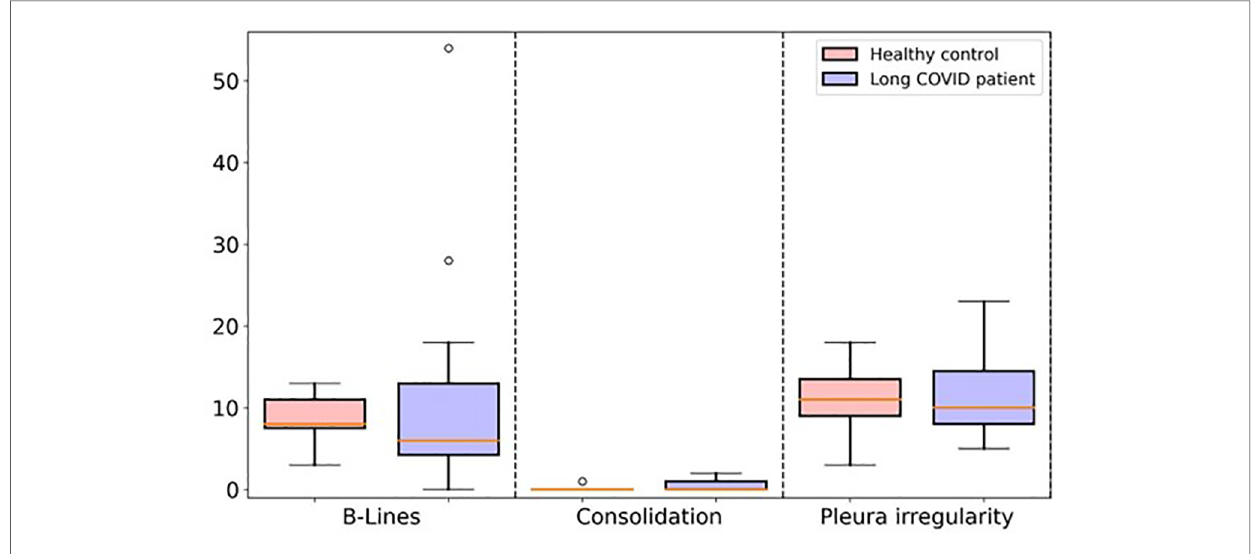
FIGURE 3 Boxplot comparing the total number of B-lines, consolidations, and pleural irregularity between long COVID study group and healthy control group.